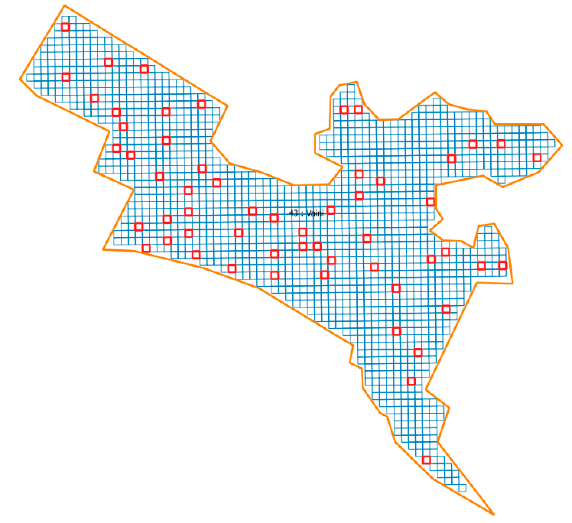
Figure 4. Distribution of the randomly selected 200 m × 200 m segments (in red) used for photointerpretation of the coconut tree counts in the Vaini region. Total area of the Vaini region is 64.2 km 2 .